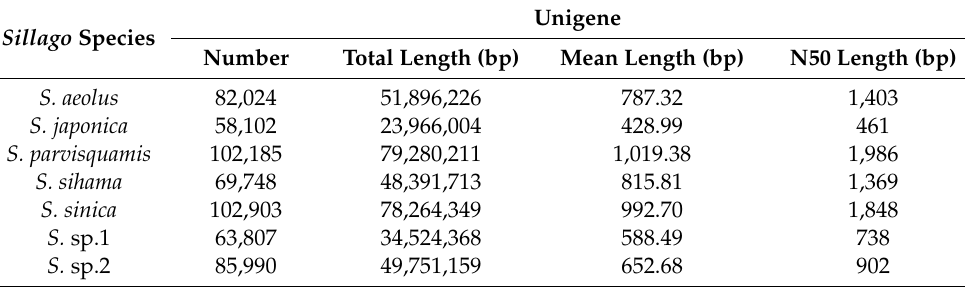
Table 3. The transcriptome assembly information of the seven Sillago